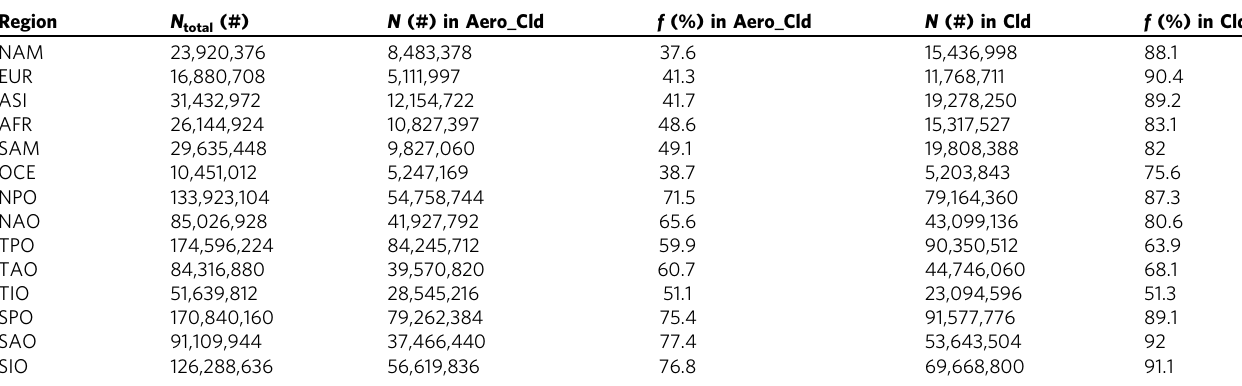
Table 1 The total number of samples in All_Cld ( N total ), and the number of samples ( N ), averaged cloud fraction ( f ) in Aero_Cld and Cld, respectively, for the fourteen regions over the period 2002 –